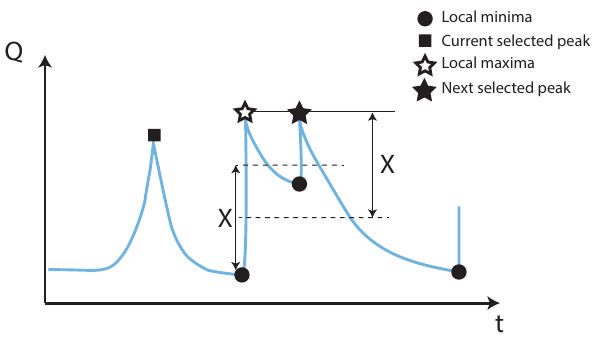
Figure 4. Illustration of the peak extraction algorithm. The square represents the most recent recession peak identified for selection. The empty star identifies a local maximum that will not be selected due to the fact that the subsequent recession does not decay by an amount X before the next local maximum. The filled star is selected as a recession peak because it is at least X greater than the lo- cal minimum between it and the previously selected recession peak (square), and is followed by a flow decrease of at least X